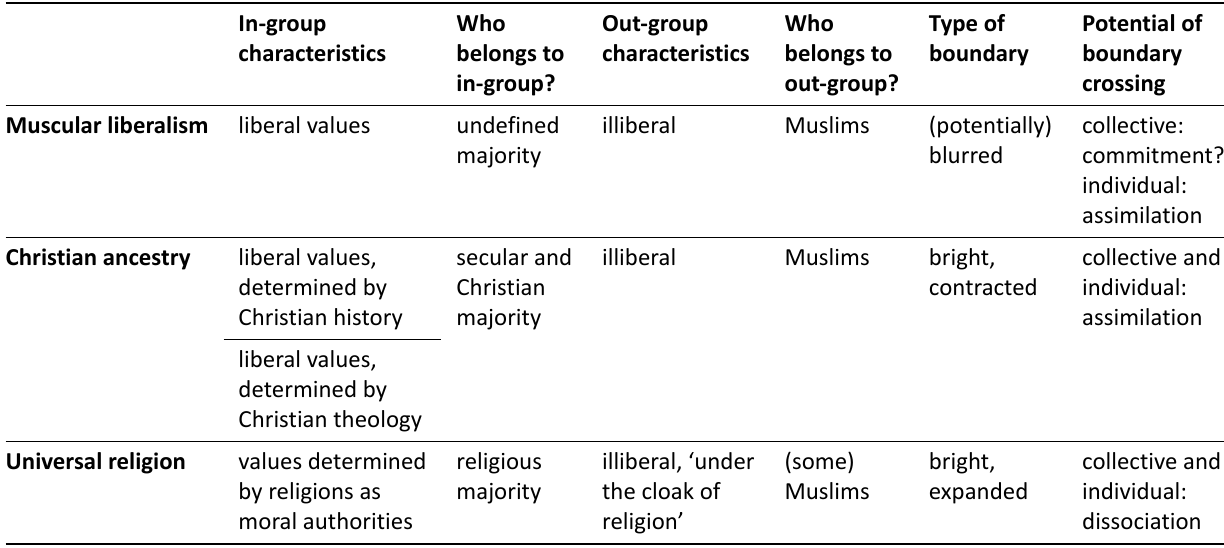
Table 2. Patterns of religion as a symbolic boundary. In-group Who Out-group Who Type of Potential of characteristics belongs to characteristics belongs to boundary boundary in-group?